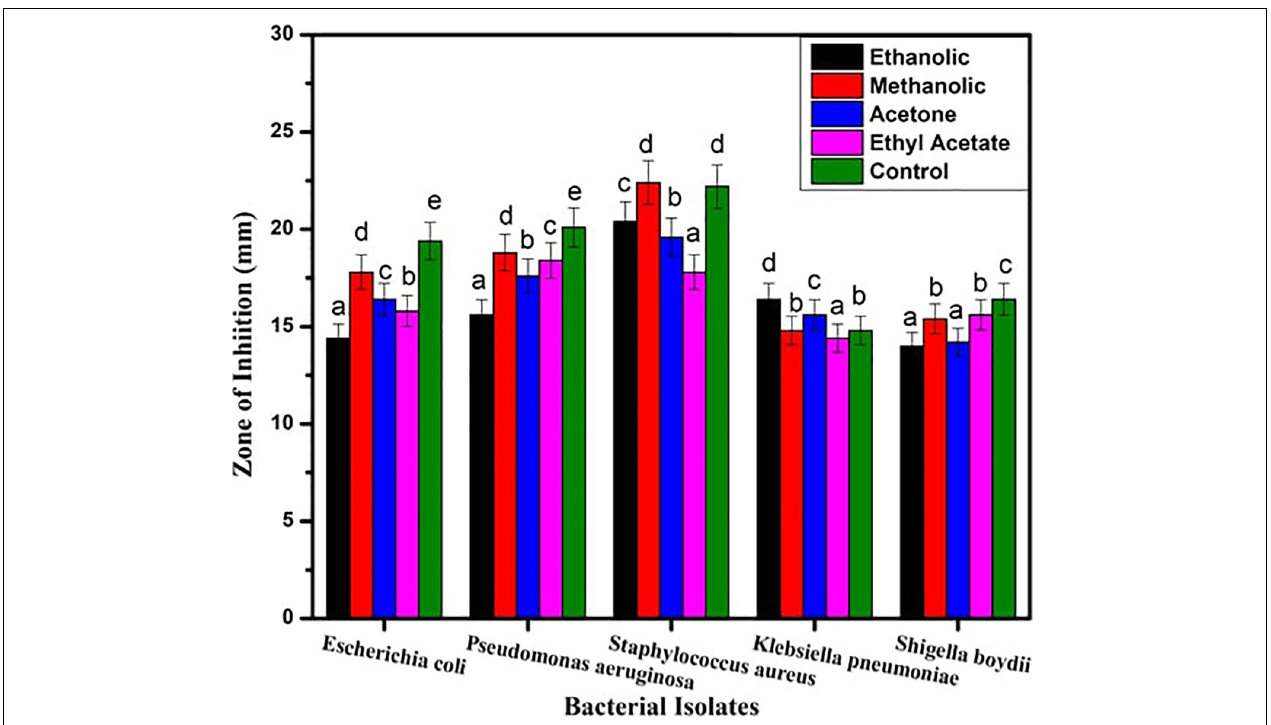
FIGURE 2 | Antimicrobial activity exhibited by crude extract of B. seminalis JRBHU6 obtained in different organic solvents against various bacteria. Results are expressed as means of the replicates with the vertical bars indicating the error of the means. Different letters indicate significant differences among treatments results according to Duncan’s multiple range test at P <